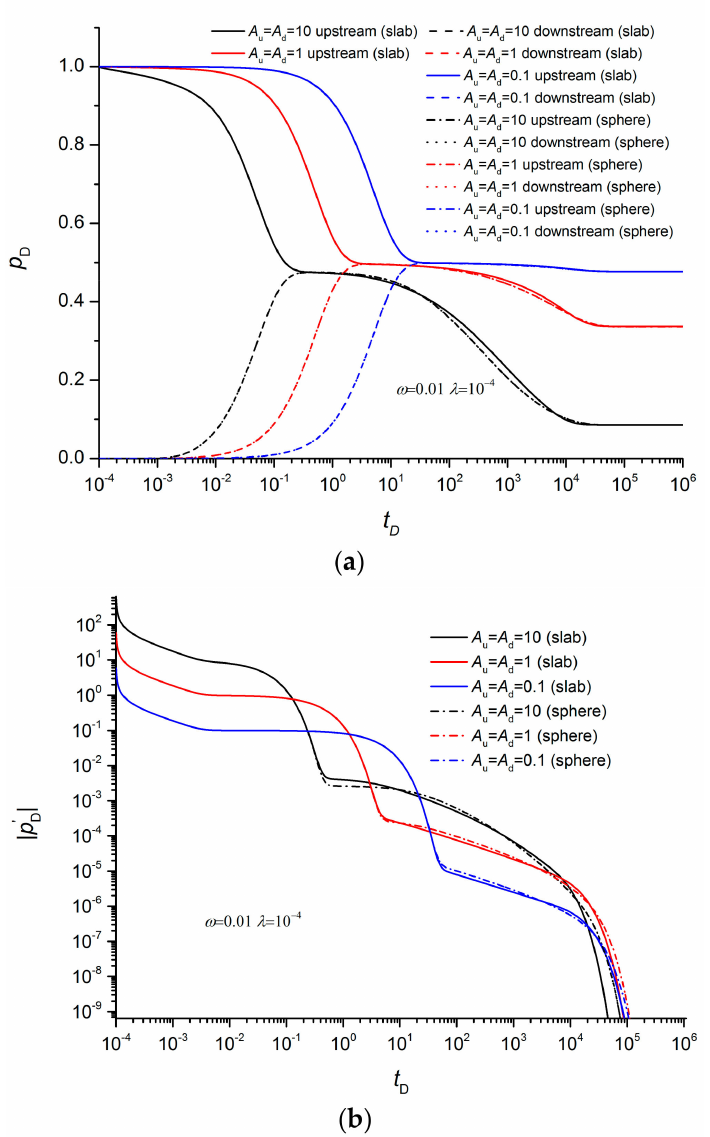
Figure 3. E ff ect of vessel volume on the pulse decay test for dual-porosity cores. ( a ) Pressure history. ( b ) Pressure